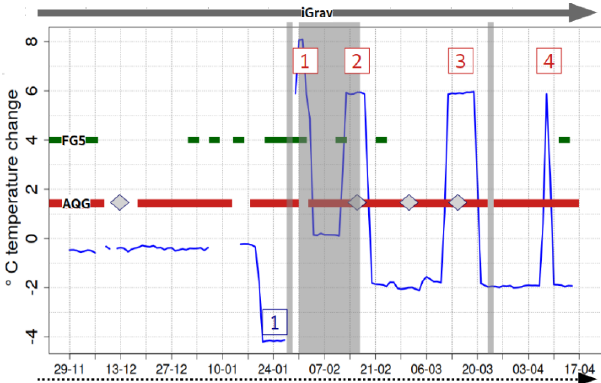
Table 1. Temperature test periods in the Larzac